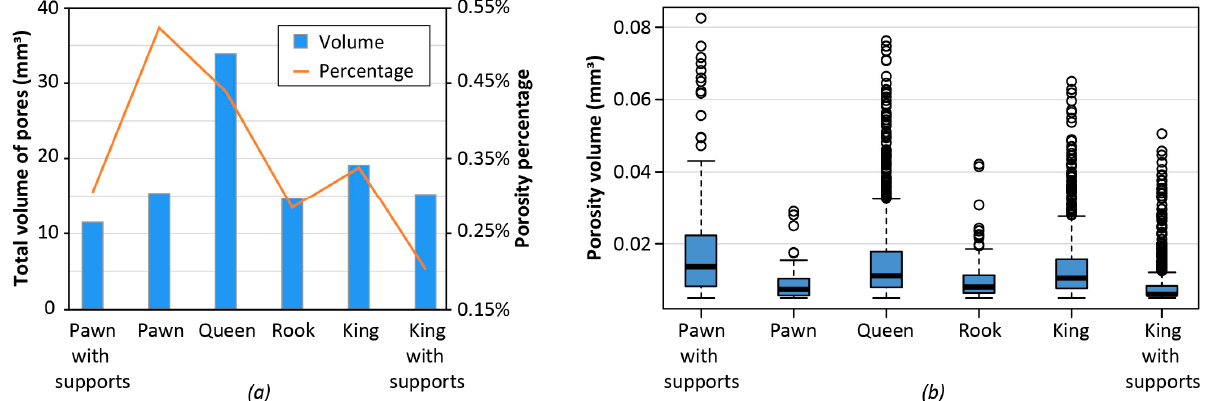
Figure 10. Porosity analysis of a complete replica of 3D printed chess pieces: ( a ) total volume of pores for the 3D printed chess pieces; ( b ) distribution of porosity volume at varying EM (excluding pores with volume lower than 0.005 mm 3 and higher than the 99th percentile).